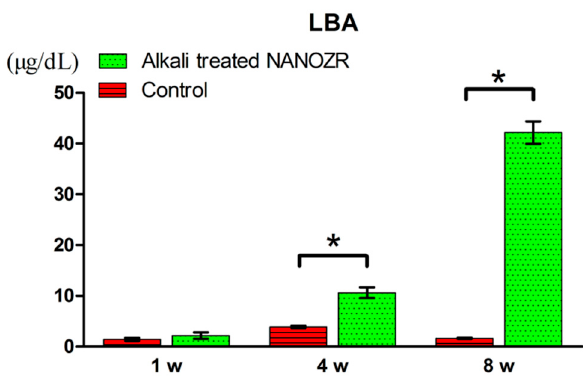
Figure 9. The percentage of labeled bone area (%LBA). * p < 0.05.